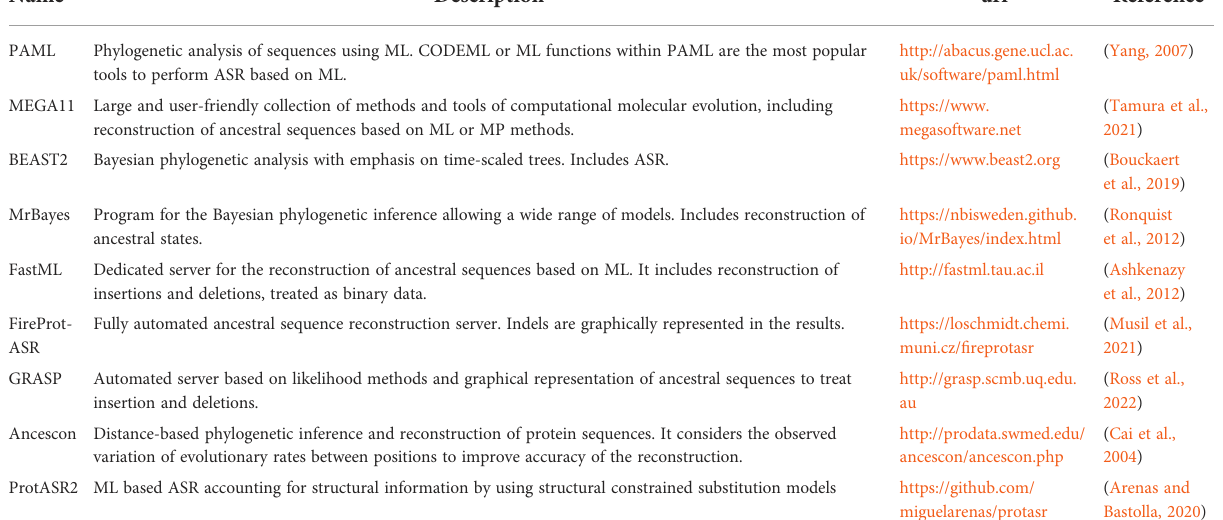
TABLE 1 Relevant methods to perform